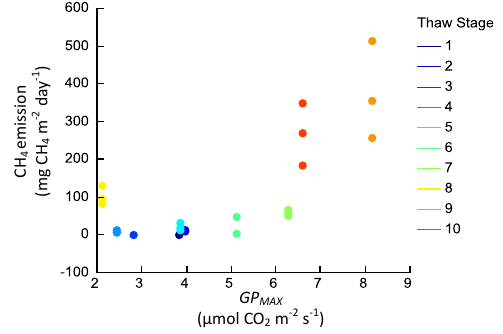
Figure 7. Relationship between growing season means of CH 4 flux and GP MAX (gross photosynthetic CO 2 capture at maximum PAR) across all thaw stages. Thaw stages 1 (intact permafrost) to 10 (thawed permafrost) are shown using blue to red colors, respec-